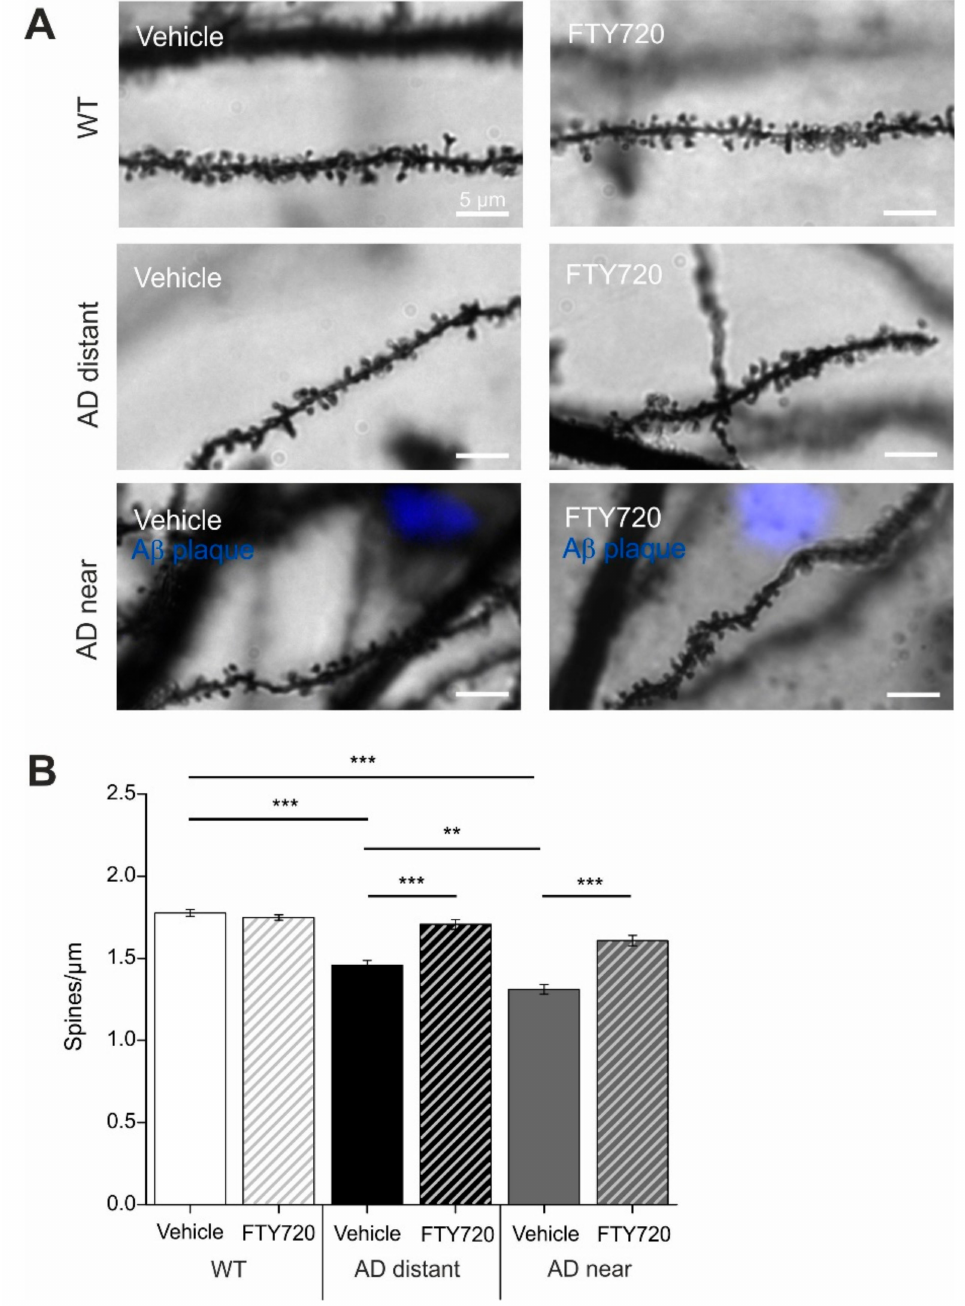
Figure 2. Chronic fingolimod (FTY 720) treatment rescues spine deficits in APP / PS1 mice. Five- to six-month-old male APP / PS1 mice were treated with intraperitoneal (i.p.) injections of